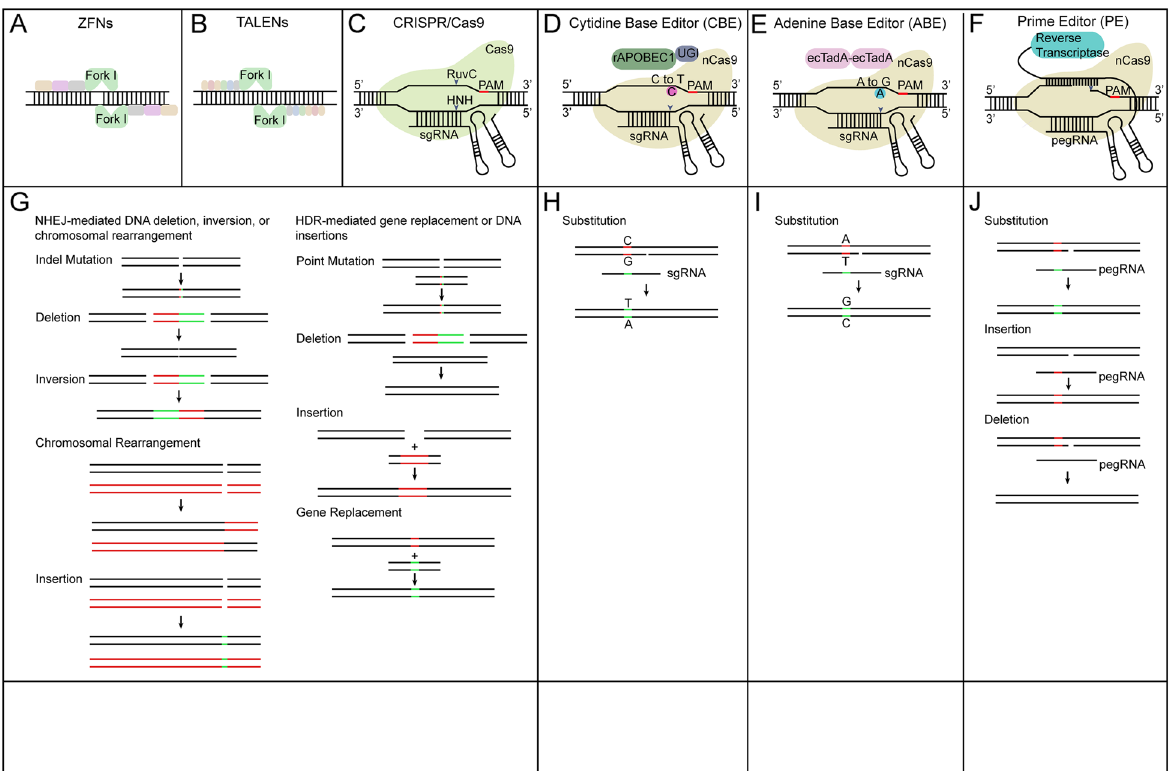
Fig. 2 Schematics of genome editing technology systems and genome modifications generated by different systems. A ZFNs technology contains an array of engineered zinc finger proteins fused to catalytic domain of the FokI endonuclease. B TALENs have arrays of the TAL effector fused with FokI. C CRISPR/Cas9 system which is composed of Cas9 protein and sgRNA. ( D ) The cytidine base editor (CBE). Green circle represents cytidine deaminase rAPOBEC1. Purple circle represents uracil glycosylase inhibitor (UGI). E The adenine base editor (ABE). Light purple circle represents adenine deaminase TadA. F Prime editing technology. The prime editor (PE) is made up of a fusion protein of nCas9 (H840A) with reverse transcriptase and a prime editing guide RNA (pegRNA). G ZFNs, TALENs and CRISPR/Cas9 deliver double strand breaks (DSBs). DNA repair pathway includes the DNA non-homologous end joining (NHEJ) repair pathway and homology directed repair (HDR) pathway. DNA repair pathway produce different forms of genome modifications. H CBE generates base substitution of C•G to A•T without DSBs. I ABE make base substitution of A•T to G•C without DSBs. J PE generate precise genome modification of DNA substitution, insertion and